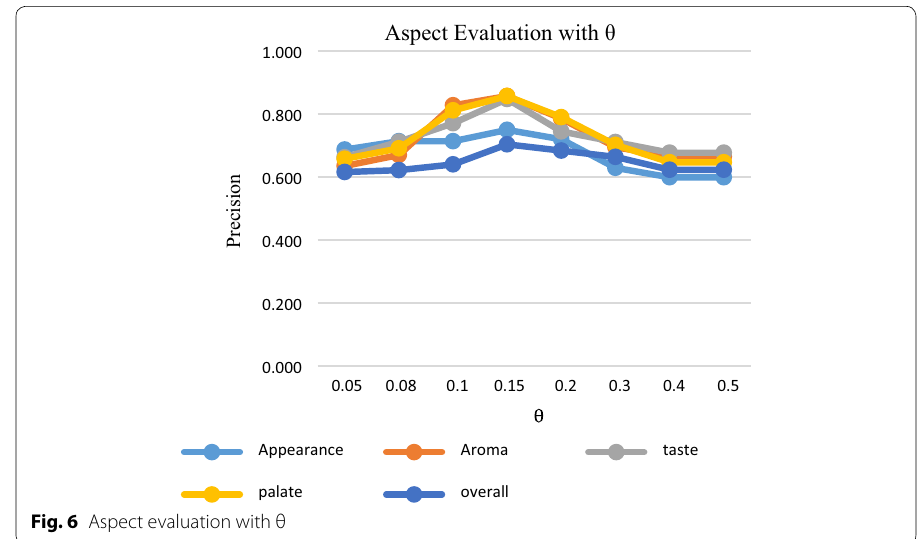
Fig. 6 Aspect evaluation with